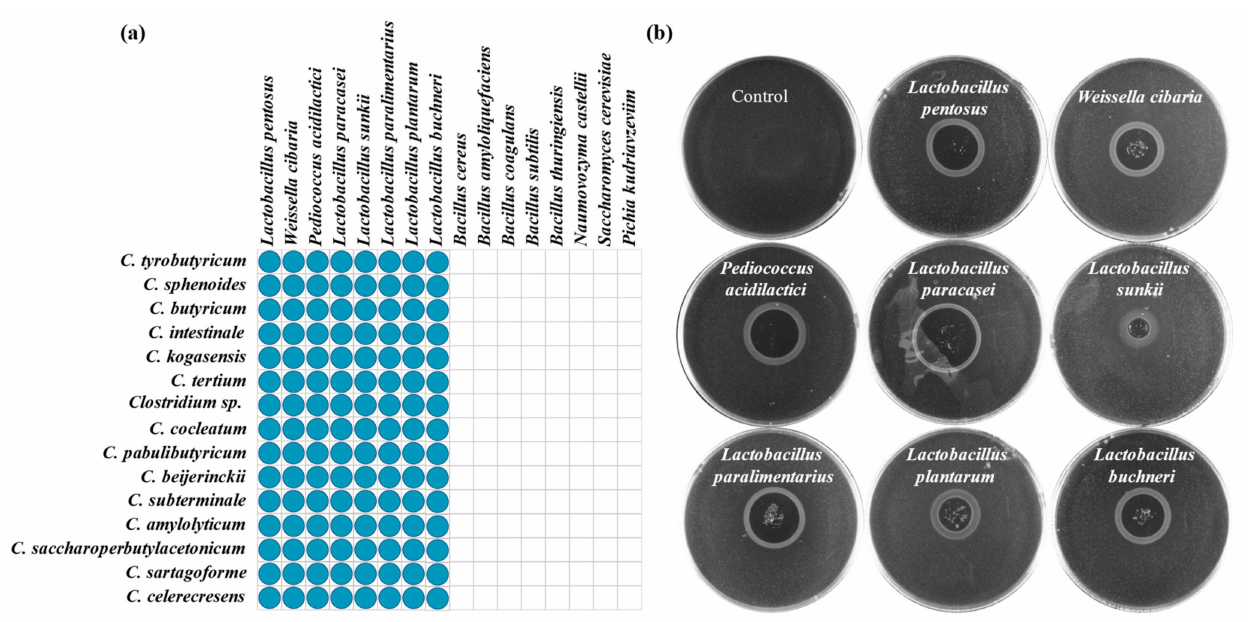
Figure 4. Chemotaxis of Clostridium to microorganisms that involved in Baijiu fermentation: ( a ) chemotaxis of Clostridium to LAB, Bacillus and yeast; ( b ) detection of chemotaxis of Clostrid- ium to LAB using the agar disc